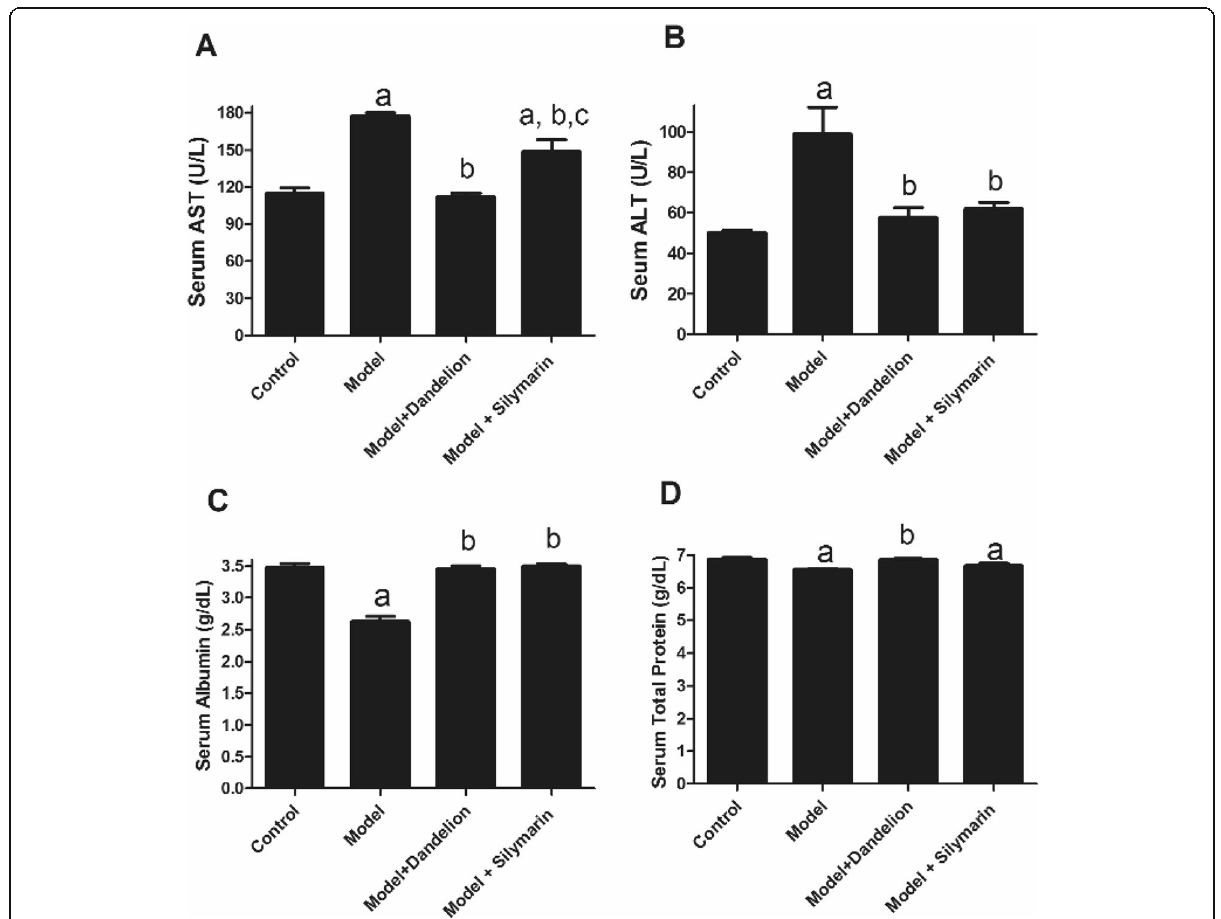
Fig. 2 Effect of dandelion and silymarin on serum markers of liver function in CCL4-treated (model). Data are expressed as mean ± SEM for six animals in each group. Units of ALT and AST are IU/L; units of albumin and T. protein are g/dl. a P < 0.05 vs. control group. b P < 0.05 vs. model